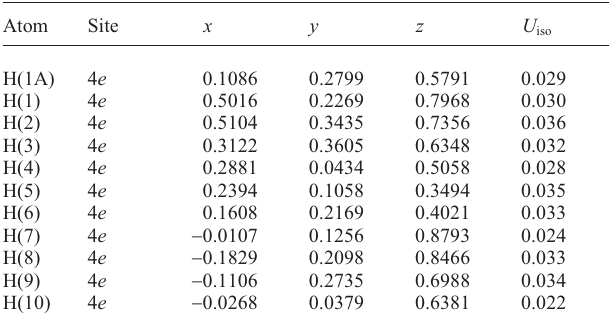
Table 1. Data collection and handling. Table 2. Atomic coordinates and displacement parameters (in Å 2 )